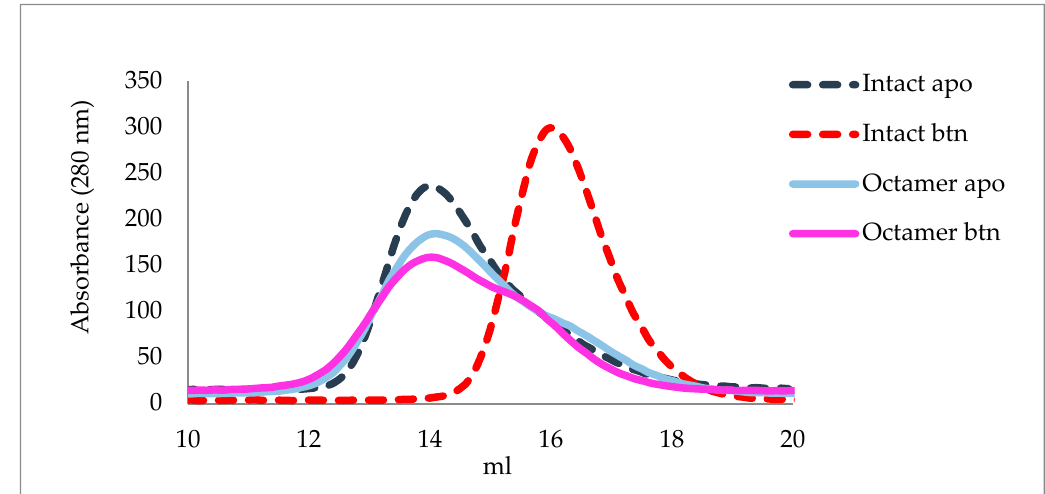
Figure 4. Size exclusion chromatography of wt and P61C hoefavidins in the apo and biotin complexed forms. The wt apo hoefavidin (dashed blue curve) displays a shift upon the biotin binding (dashed red curve) indicating dissociation of the octameric assembly solely into dimers. The P61C hoefavidin does not exhibit any major shift upon biotin binding, showing a similar profile for both forms (apo in cyan and biotin complex magenta). Additionally, the heterogeneity of the P61C peaks indicates that the P61C mutant is heterogeneous in solution. 3.3. Obtaining a Homogeneous Octameric Sample